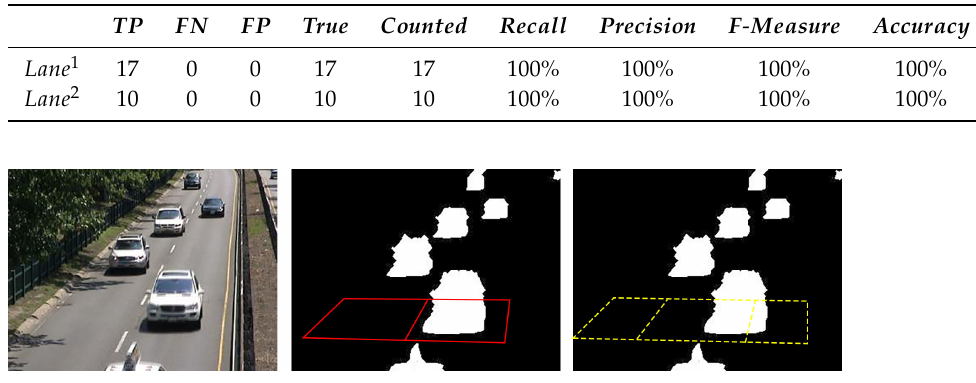
Figure 16. Example of the experimental results in Video II. Table 11. Experimental results of Video III.